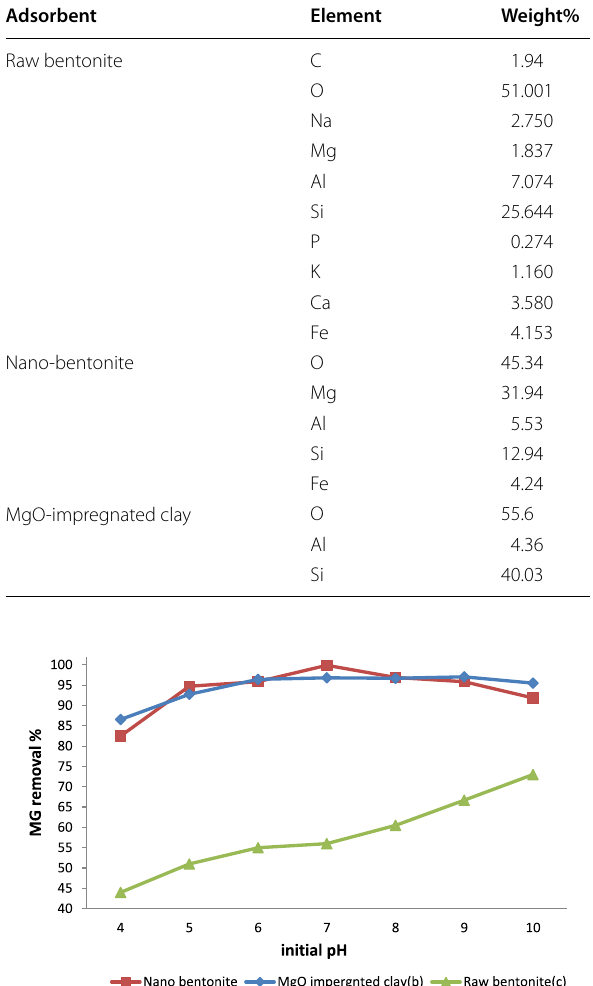
Table 1 DEX elemental analysis of raw bentonite, nano- bentonite and MgO-impregnated clay Adsorbent